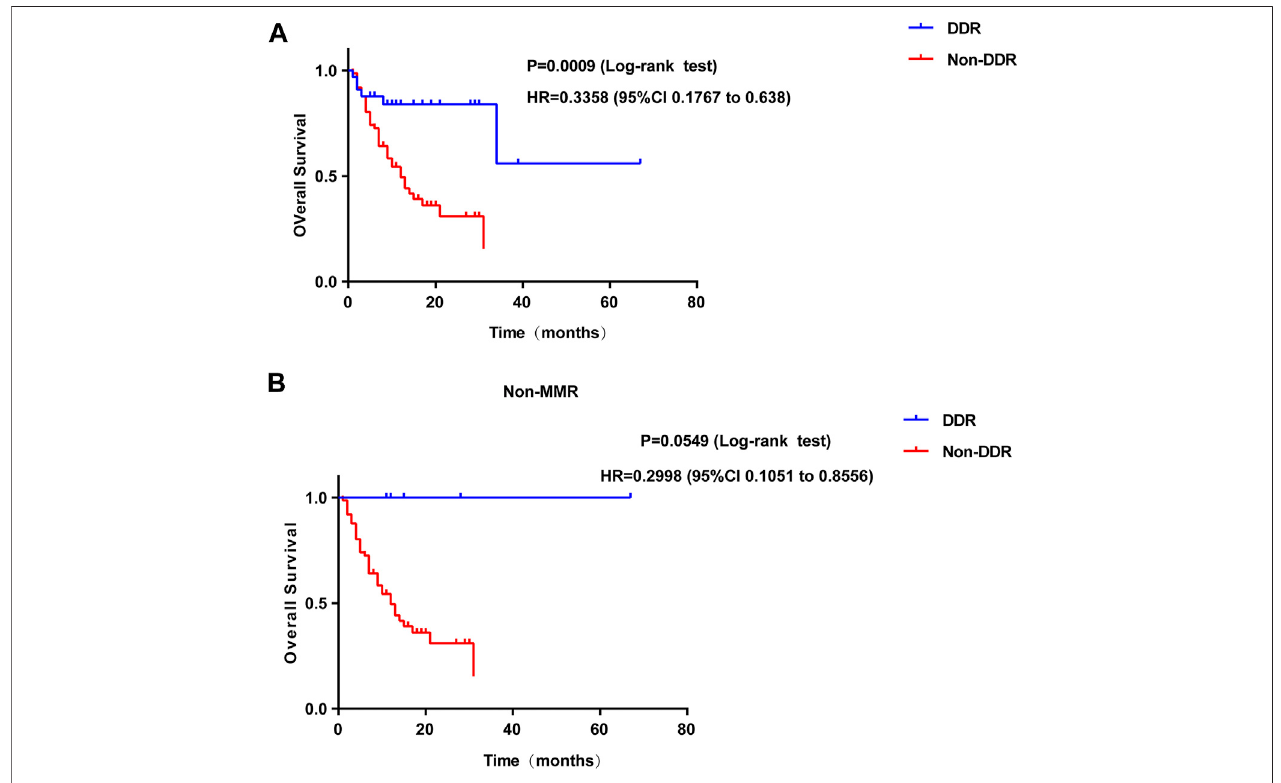
FIGURE 9 | Survival curves of OS comparing DDR mutation (A) or DDR without MMR mutation (B) (blue) with Non-DDR (red) in colorectal patients from immunotherapy cohort. OS: overall survival; DDR: DNA damage response.